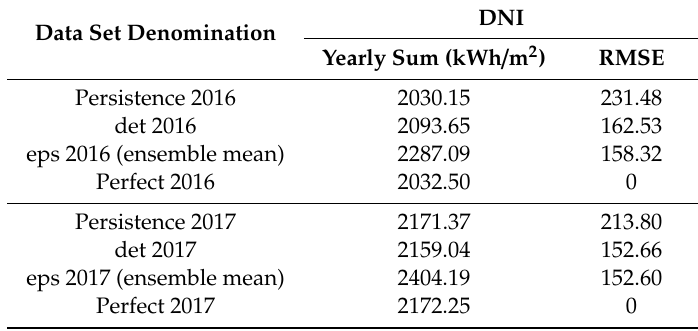
Table 3. Badajoz data direct normal irradiation (DNI) yearly sum and root-mean-square error